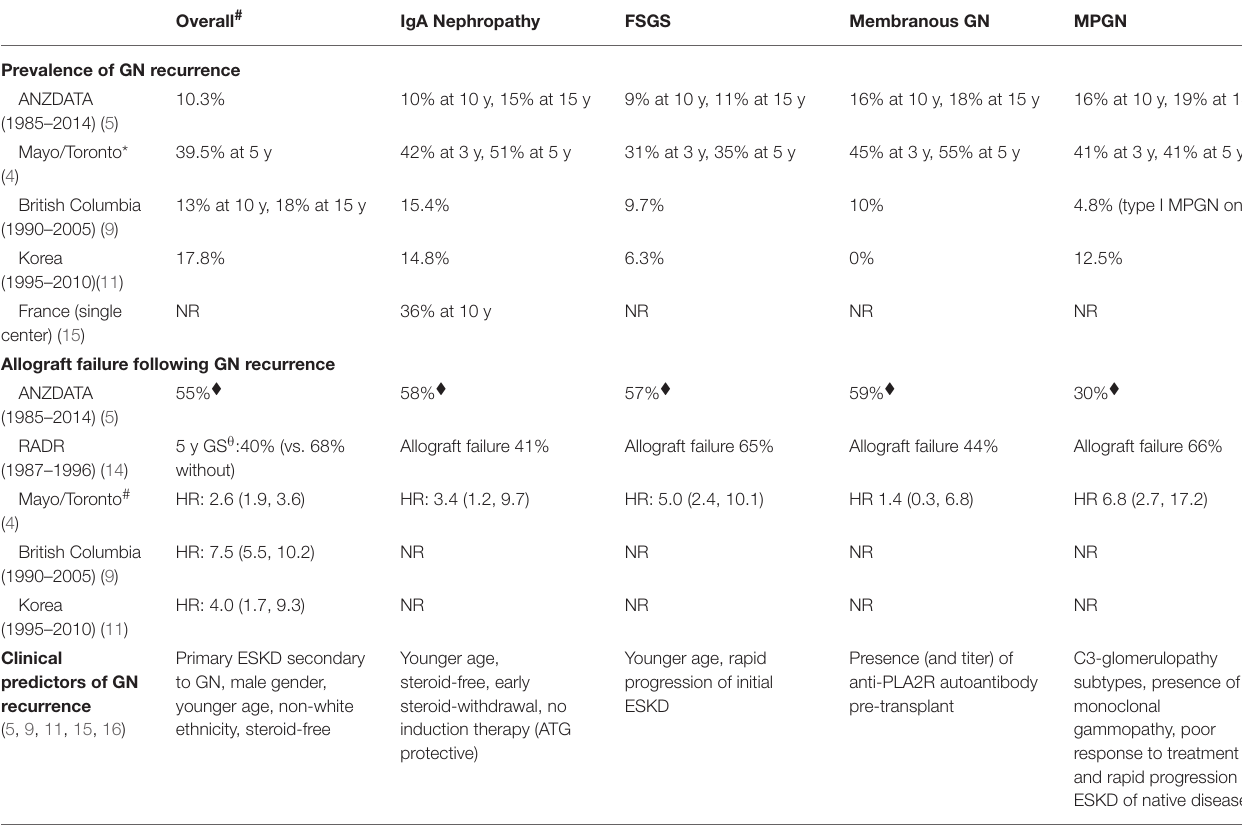
TABLE 1 | Prevalence, risk of allograft failure and clinical predictors of glomerulonephritis recurrence post-kidney transplantation. Overall # IgA Nephropathy FSGS Membranous GN MPGN Prevalence of GN